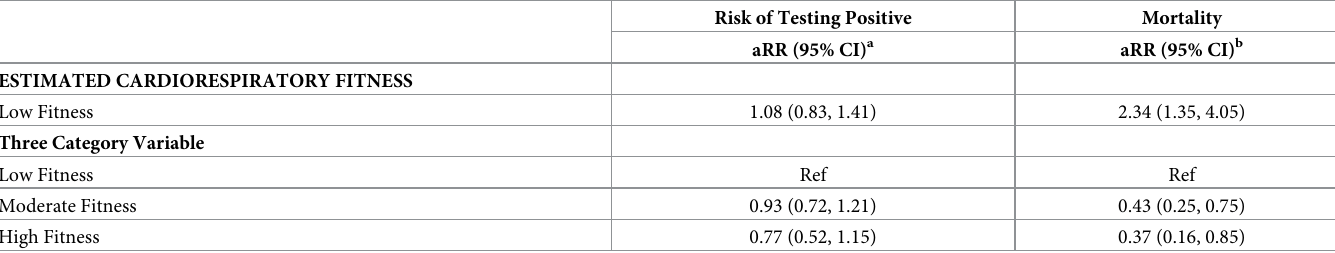
Table 2. Association between estimated cardiorespiratory fitness (eCRF) and testing positive for COVID-19 and COVID-19